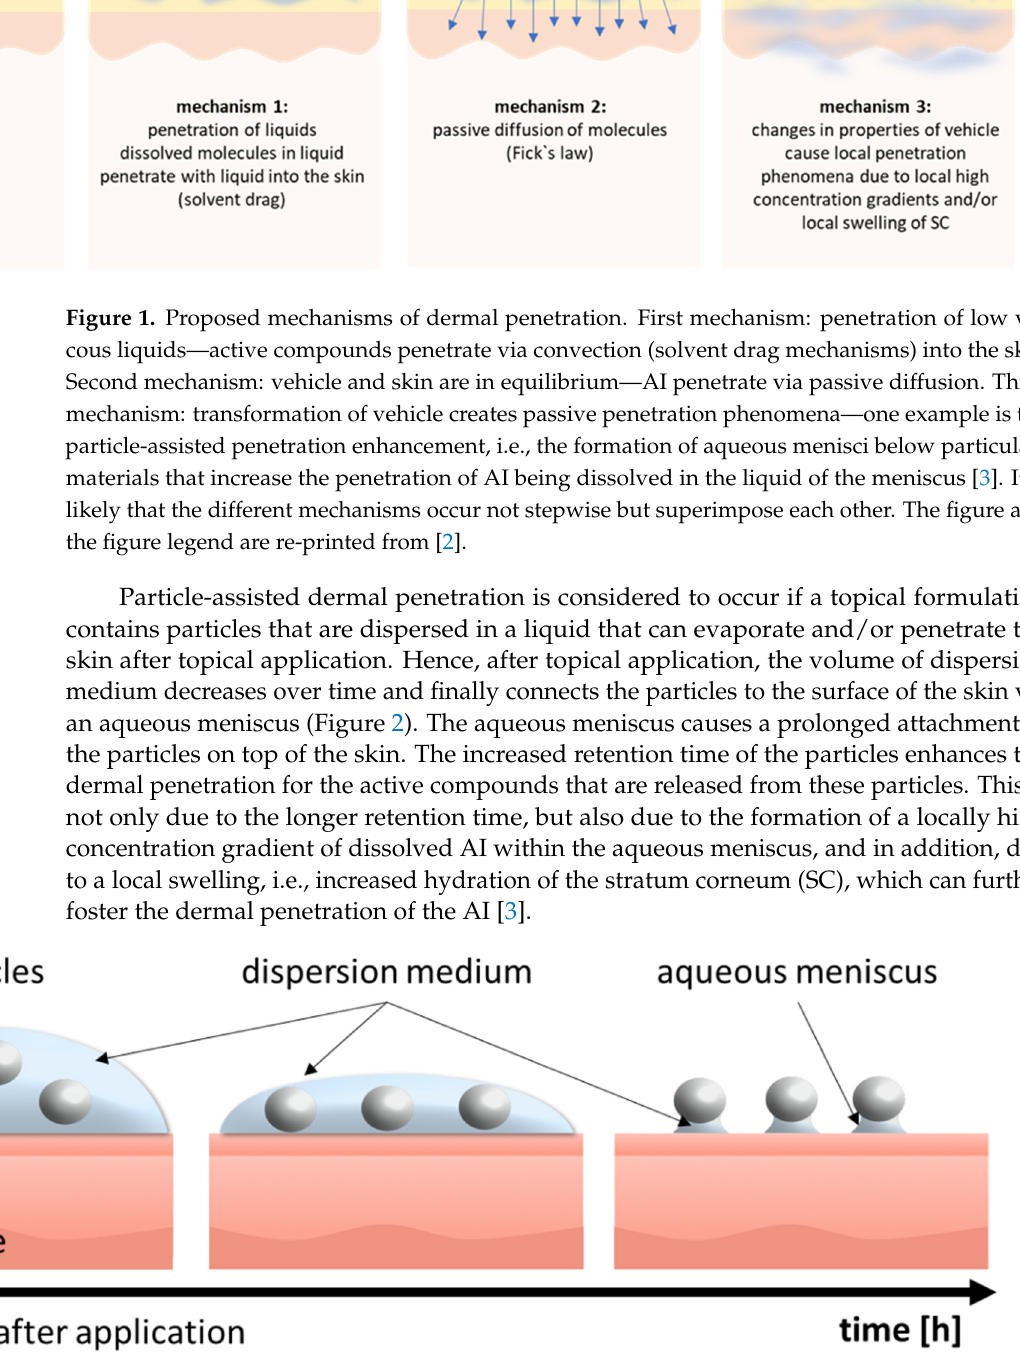
Figure 2. Scheme of aqueous meniscus formation after topical application of particle-containing dermal formulations.